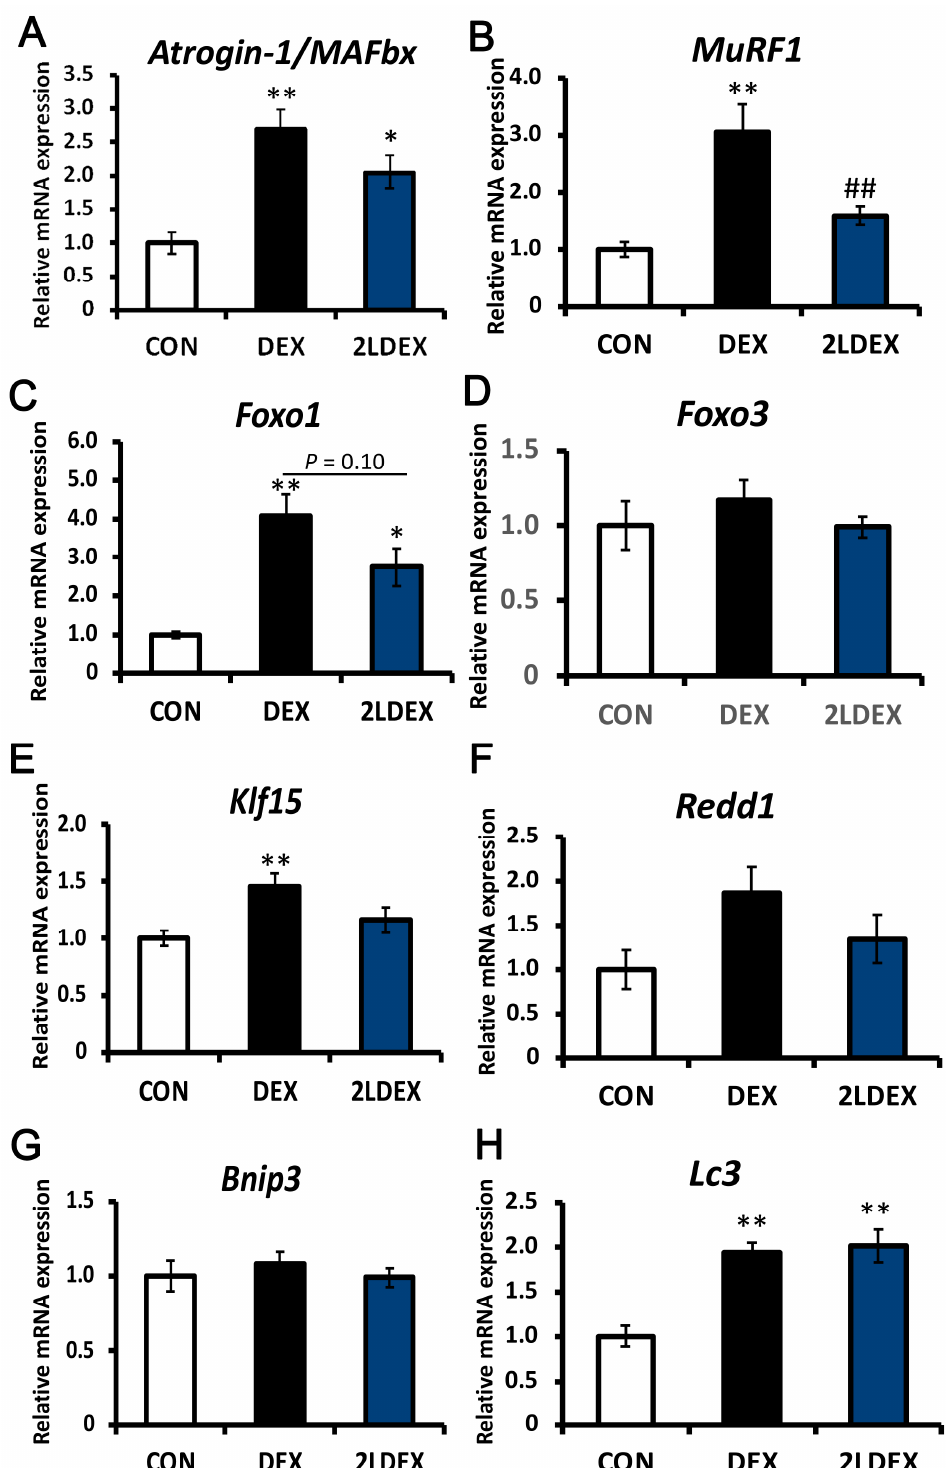
Figure 4. Effects of laurel on key regulatory checkpoints of the ubiquitin-proteasome and autophagolysosome systems in rat tibialis anterior muscle atrophy. mRNA levels of ( A ) atrogin-1/MAFbx, ( B ) MuRF1, ( C ) Foxo1, ( D ) Foxo3, ( E ) Kif15, ( F ) Redd1, ( G ) Bnip3, and ( H ) Lc3. Data are shown as the mean ± SE ( n = 7). Statistical significance was determined by Tukey’s test. * p < 0.05, ** p < 0.01 vs. control group. ## p < 0.01 vs. DEX group.